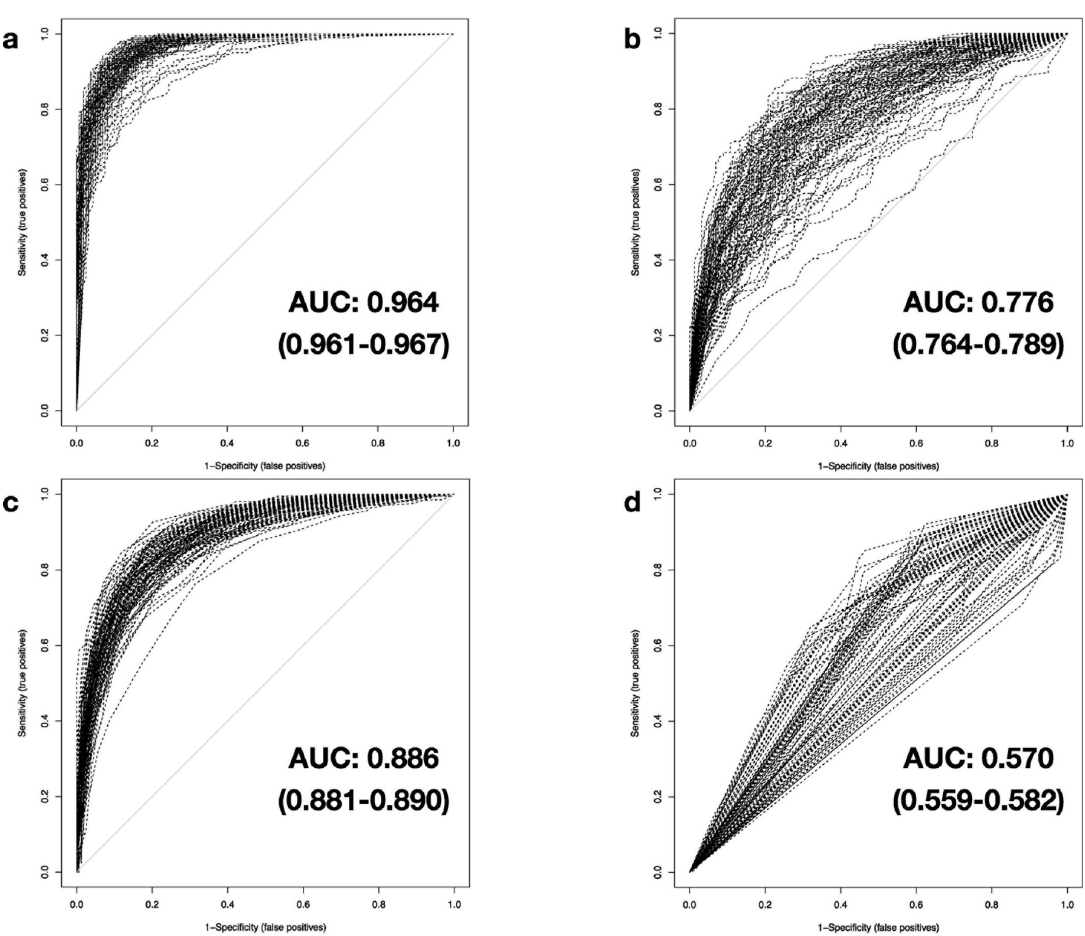
Fig 5. Comparison of classification performance with zero-replacement of 75% of testing data. The AUROC analysis results are derived from testing data with level 2 data degradation applied cumulatively to level 1, considering 1,483 genes for a) DNN, b) SVM, c) RF, and d)